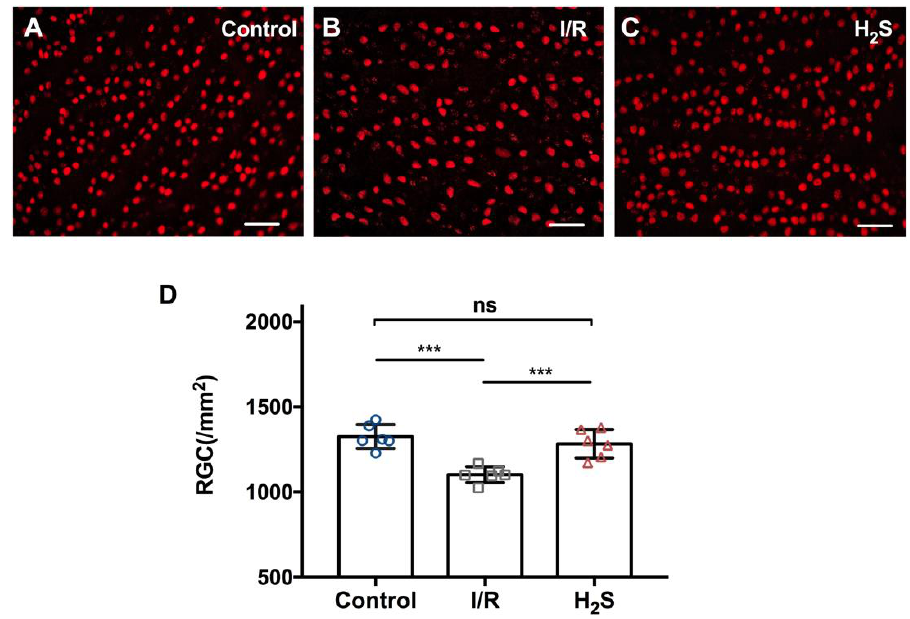
Figure 1. Pre-treatment with H 2 S protects RGC against ischemia-reperfusion injury in vivo. ( A – C ) Representative fluorescence microscopy of Brn3a staining of retinal explants 24 h after inducing ischemia / reperfusion injury in vivo. ( D ) Compared to the contralateral control (1310.6 ± 236.4 RGC / mm 2 ), ischemia-reperfusion injury resulted in significant RGC loss in experimental eyes (1101.7 ± 116.4 RGC / mm 2 ). Pretreatment with GYY4137 showed a significant reduction of RGC loss in vivo (1295.4 ± 136.1 RGC / mm 2 ). Total number of RGC between control and H 2 S treated group is not significantly di ff erent (*** p < 0.0005, n = 6 / group, means ± SD, scale bar = 50 µm ).